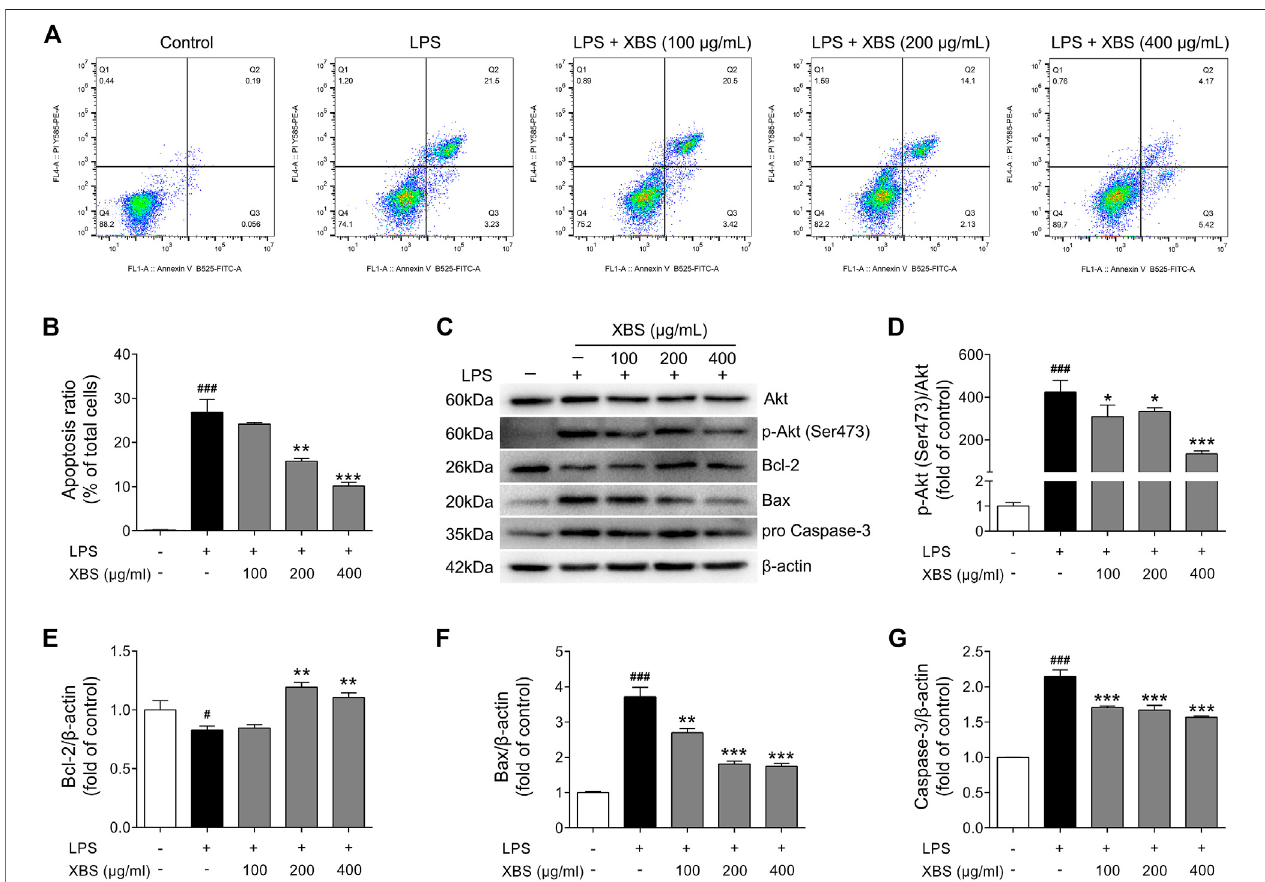
FIGURE8| EffectsofXBSoncellapoptosisinducedbyLPSinRAW264.Sevencells. (A) ThecellswerestainedwithAnnexinV-FITCandPIandtheapoptosisrate of cells was analysed by fl ow cytometry. (B) Apoptosis ratio. (C – G) Representative Western blots showing the protein of Akt, pAkt (Ser473), Bcl-2, Bax and pro Caspase-3 changes and normalized to β -actin. Similar results were obtained from three independent experiments. The values are presented as means ± SD. # p < 0.05 and ## p < 0.001 vs. the control group. * p < 0.05, ** p < 0.01 and *** p < 0.001 vs. the LPS group.